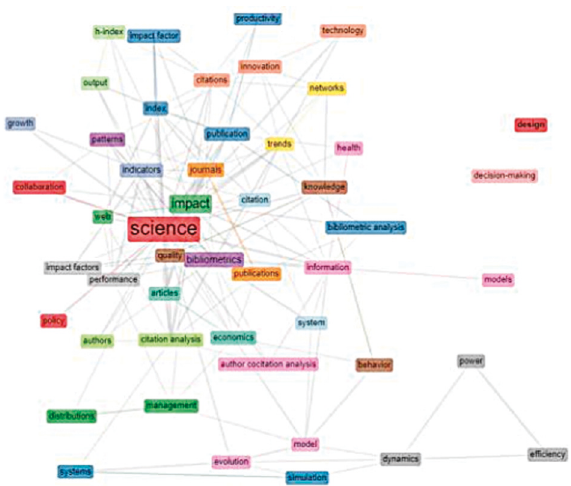
Figure 9: 2006–2010 cooccurrence network.